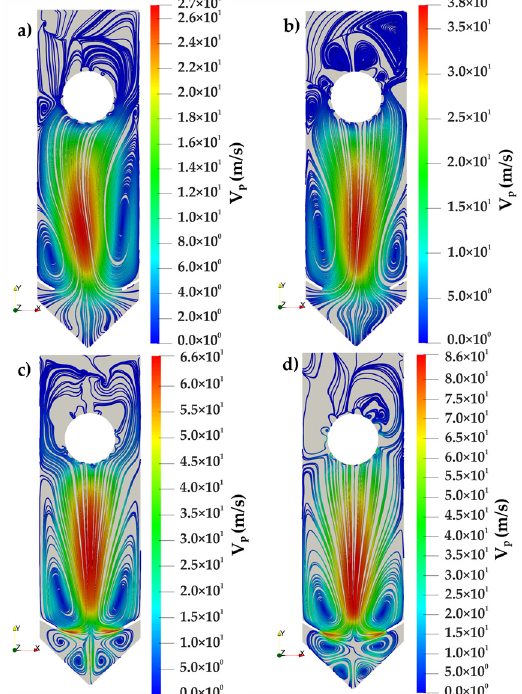
Figure 15. Streamlines based on the time-averaged particle velocity as a function of the solid holdup and the nozzle inlet pressure: ( a ) 400 g and 0.5 bar; ( b ) 400 g and 1 bar; ( c ) 700 g and 0.5 bar; ( d ) 700 g and 1 bar.